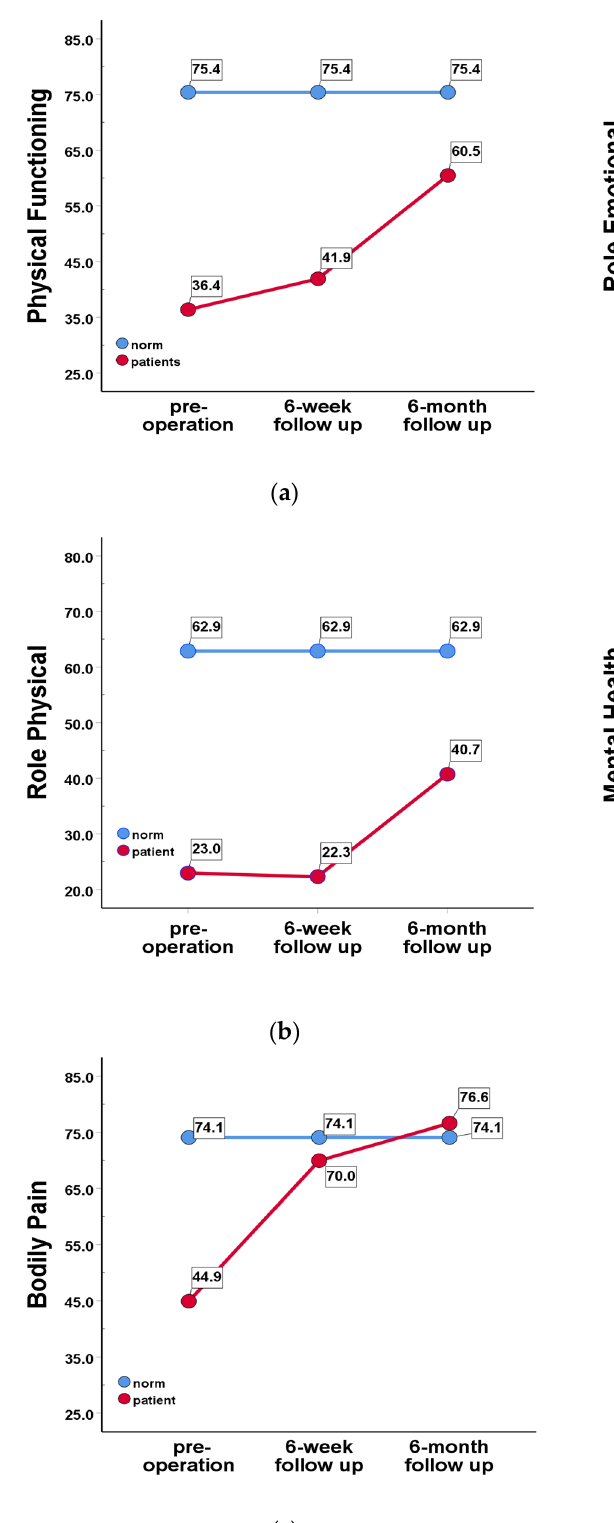
Figure 1. The SF-36 subscales at the pre-operation, 6-week follow-up and 6-month follow-up stages, and age-/sex-matched normative values: ( a ) physical functioning subscale; ( b ) role limitations due to physical health problems subscale; ( c ) bodily pain subscale; ( d ) role limitations due to emotional problems subscale; and ( e ) mental health subscale.